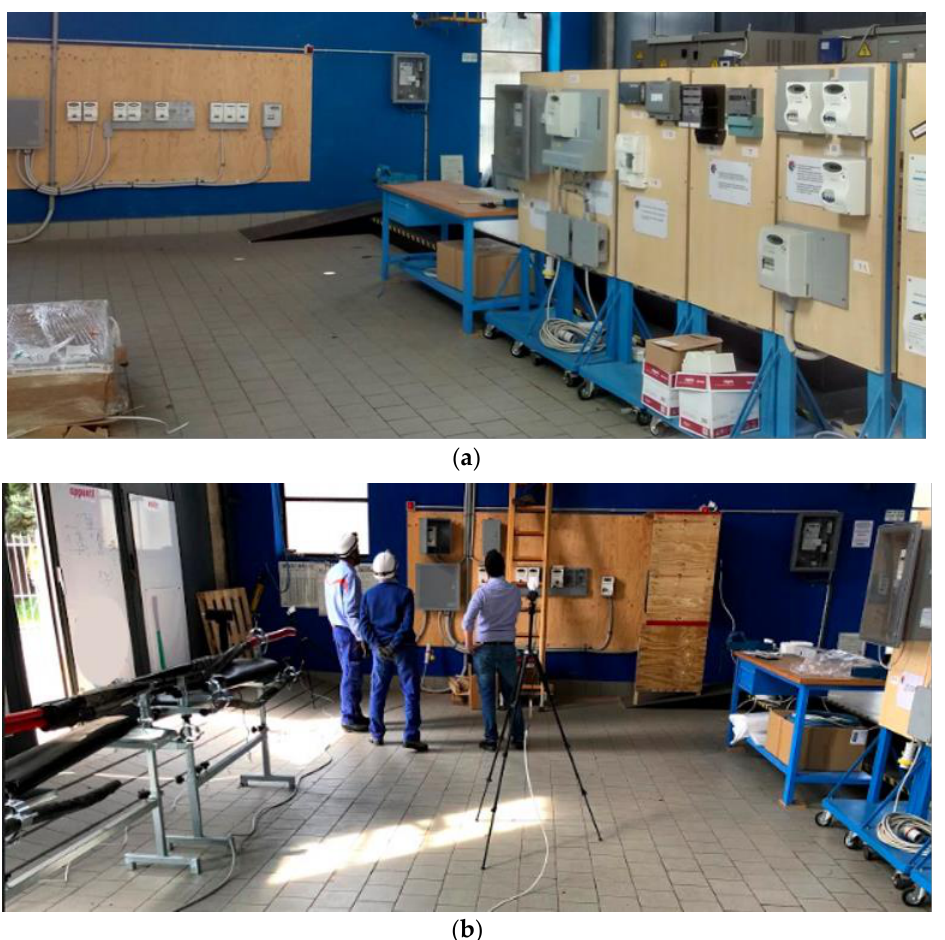
Figure 6. ( a ) The simulation center, and ( b ) the preparation of the